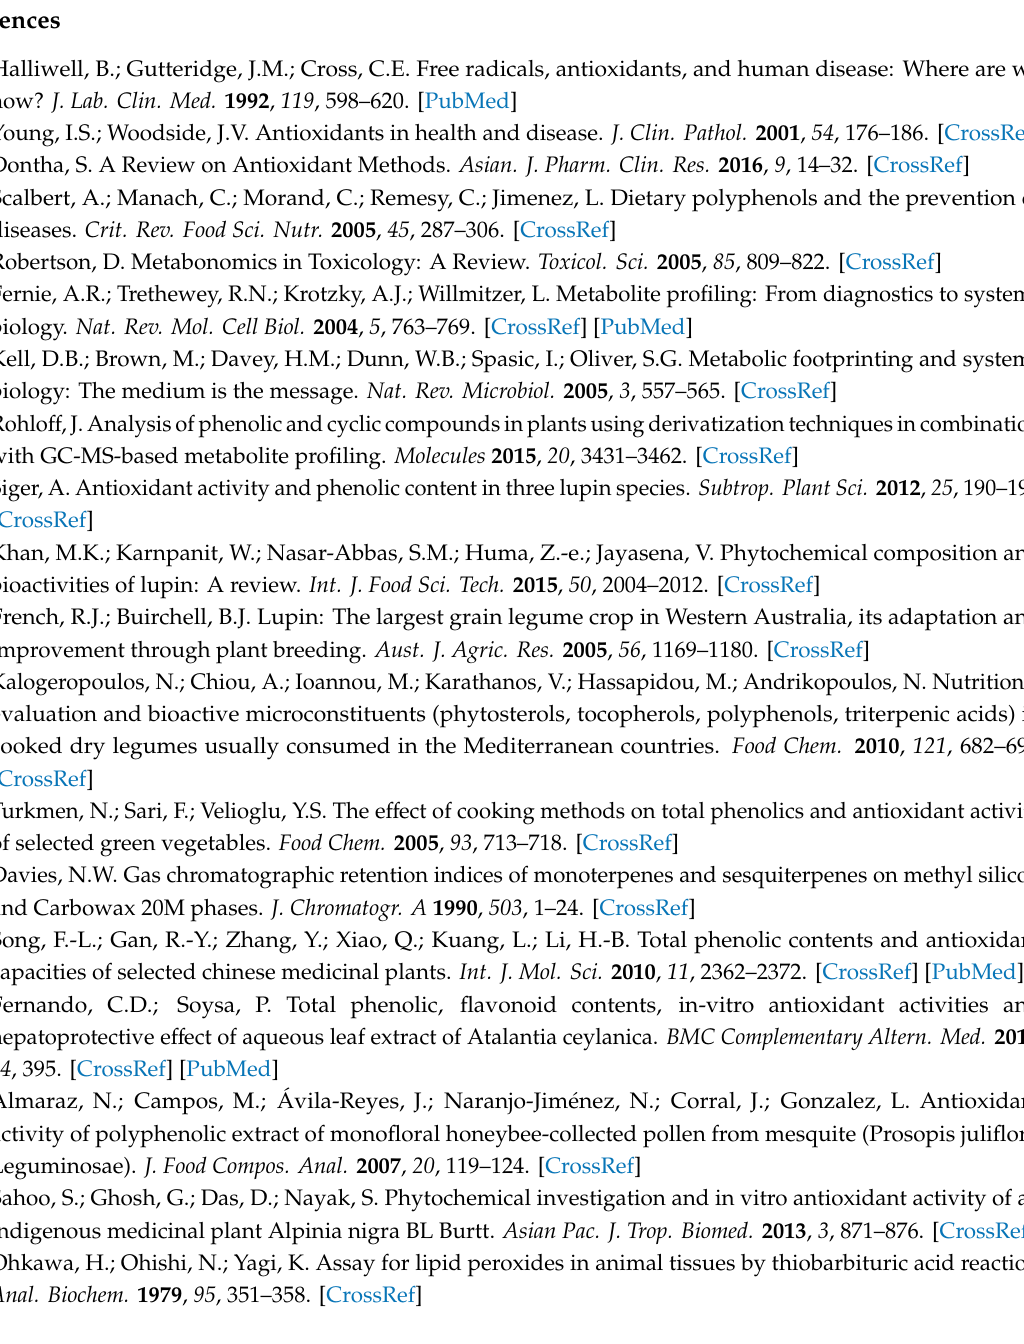
Table S1. Pharmacological activities of bioactive compounds present in lupin species, Table S2. Bioactive molecules obtained by GC-MS analysis in nine cultivars of processed and unprocessed lupin flours. Author Contributions: Conceptualization, K.M., A.F.; methodology, K.M. and A.F.; formal analysis, K.M.,